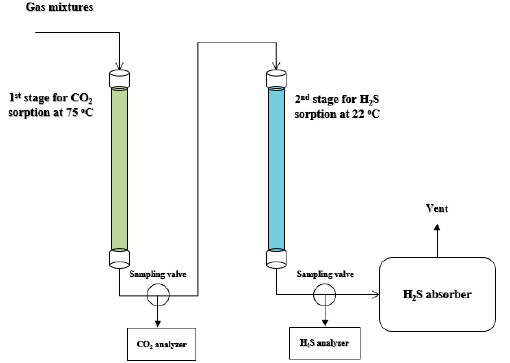
Figure 6. Schematic diagram of a two–stage CO 2 and H 2 S experimental setup (adopted from [165]).